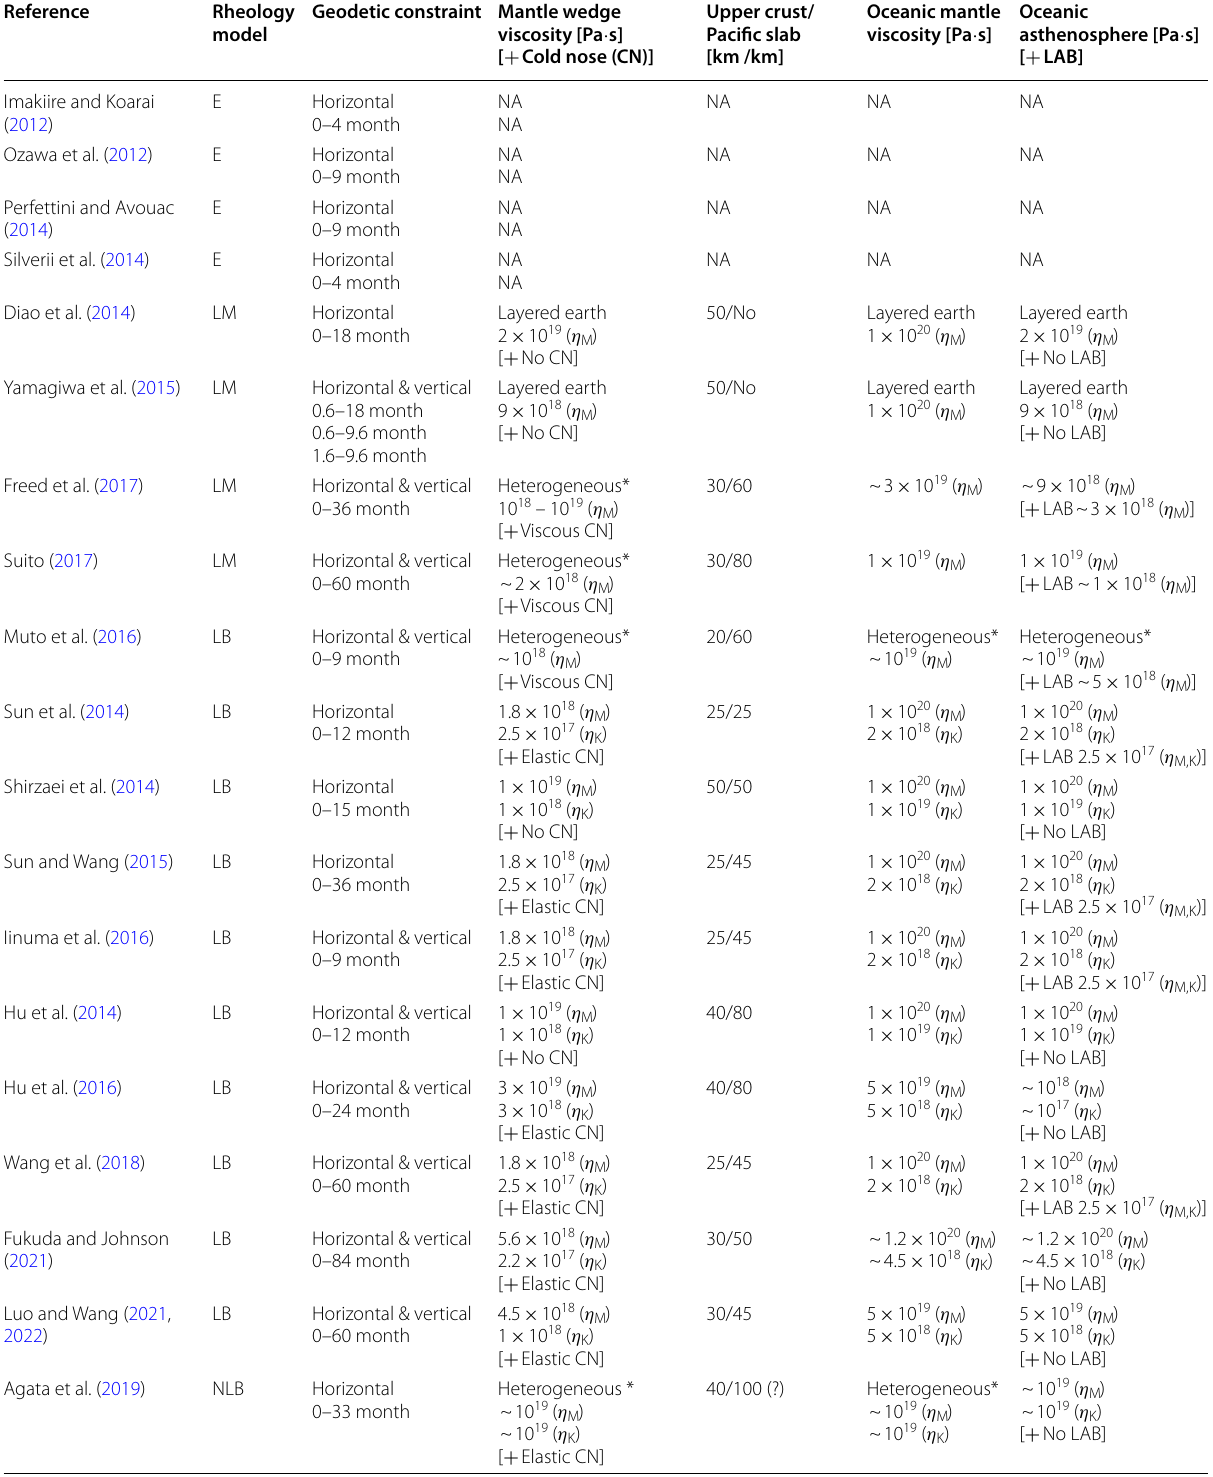
Table 1 Summary of postseismic models of the M9 2011 Tohoku-oki